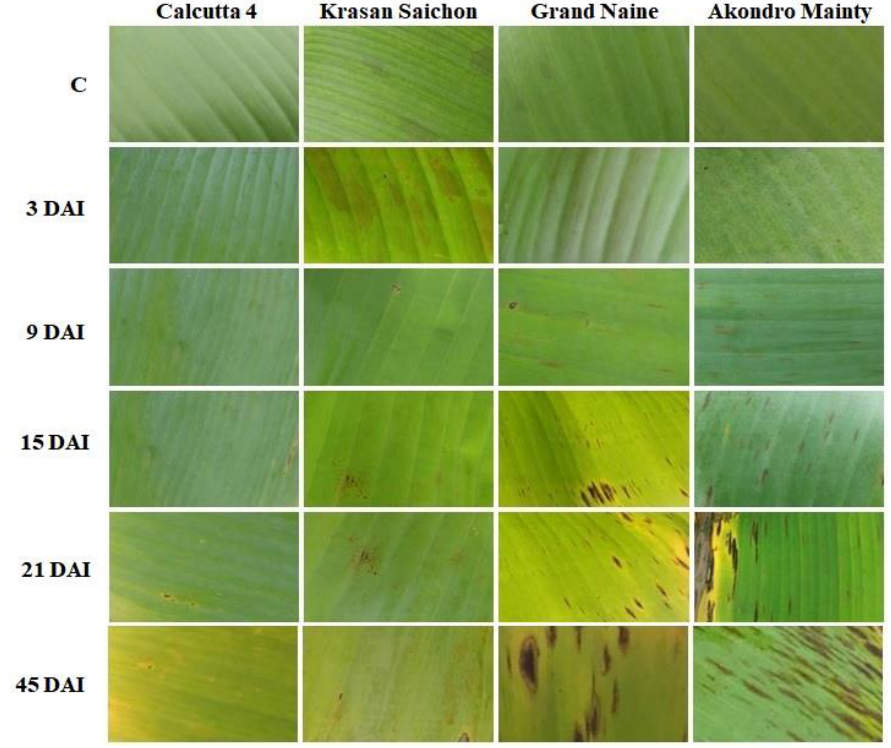
Figure 1. Progression of black Sigatoka symptoms in different banana genotypes inoculated in a greenhouse: Calcutta 4, Krasan Saichon, Grand Naine and Akondro Mainty. C: control; DAI: days after inoculation (3 – 45 DAI).